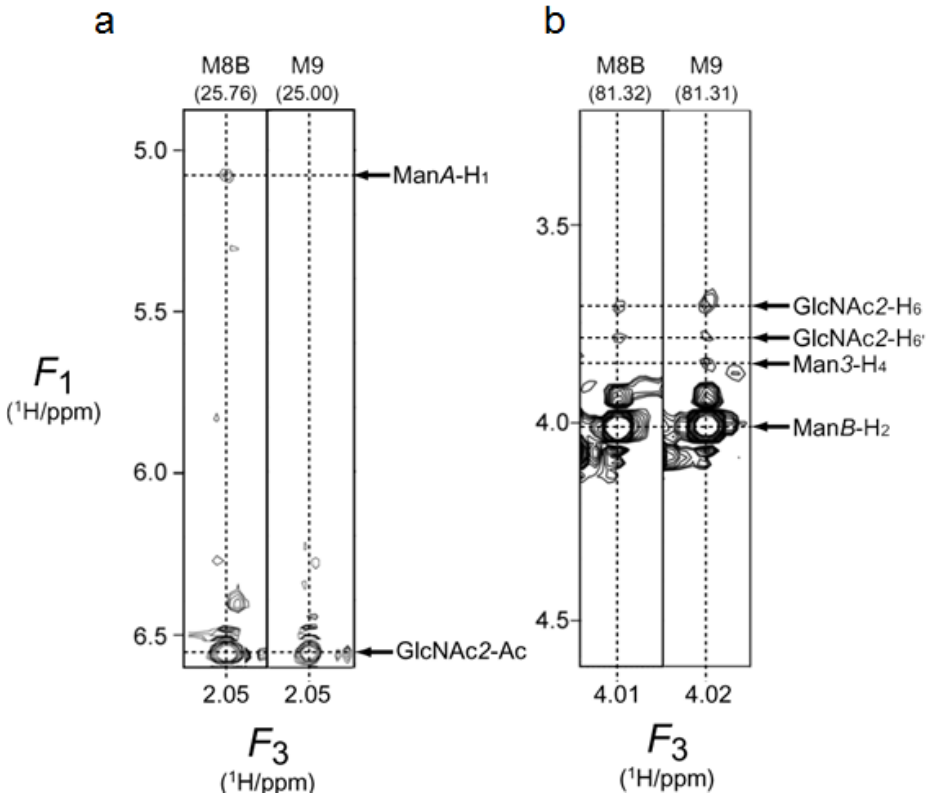
Figure 4. Part of the 13 C-edited Nuclear Overhauser effect spectroscopy (NOESY) spectra of the PA derivatives of M8B and M9 uniformly labeled with 13 C, showing connectivities from (a) GlcNAc 2 -Ac and (b) Man B -H . The spectrum was recorded at a proton 2 observation frequency of 950.3 MHz with 64 ( t ) × 80 ( t ) × 1024 ( t ) complex points and 1 2 3 two scans per t increment with a mixing time of 200 ms. The number at the top of each 1 slice is the chemical shift of 13 C resonance.